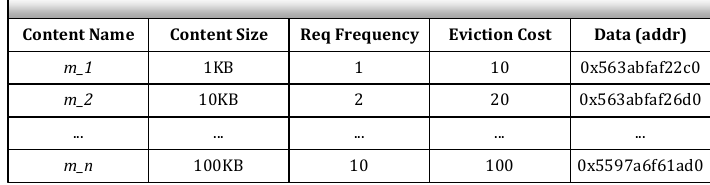
Figure 8. Forwarding process of subsequent data packets.